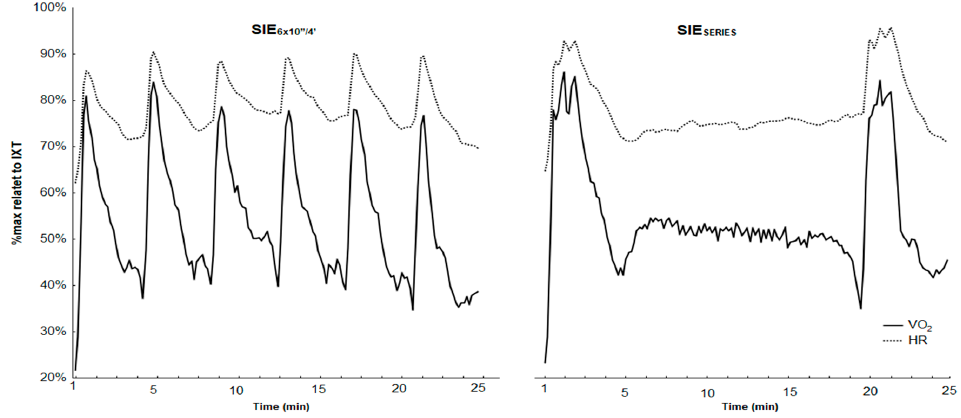
Figure 3. Related values (%max from incremental exercise test) of oxygen uptake and heart rate during and after the SIE SERIES and SIE 6×10”/4’ .